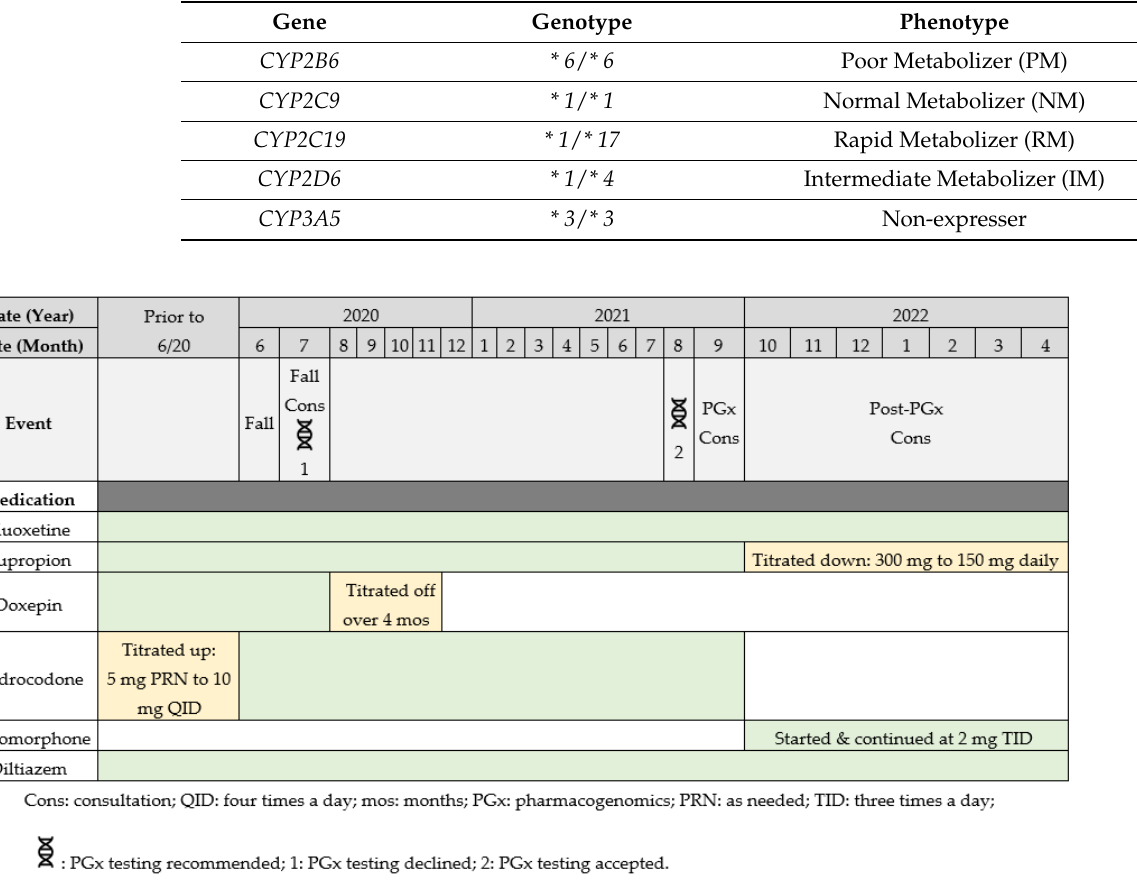
Figure 2. Timeline of events and medication